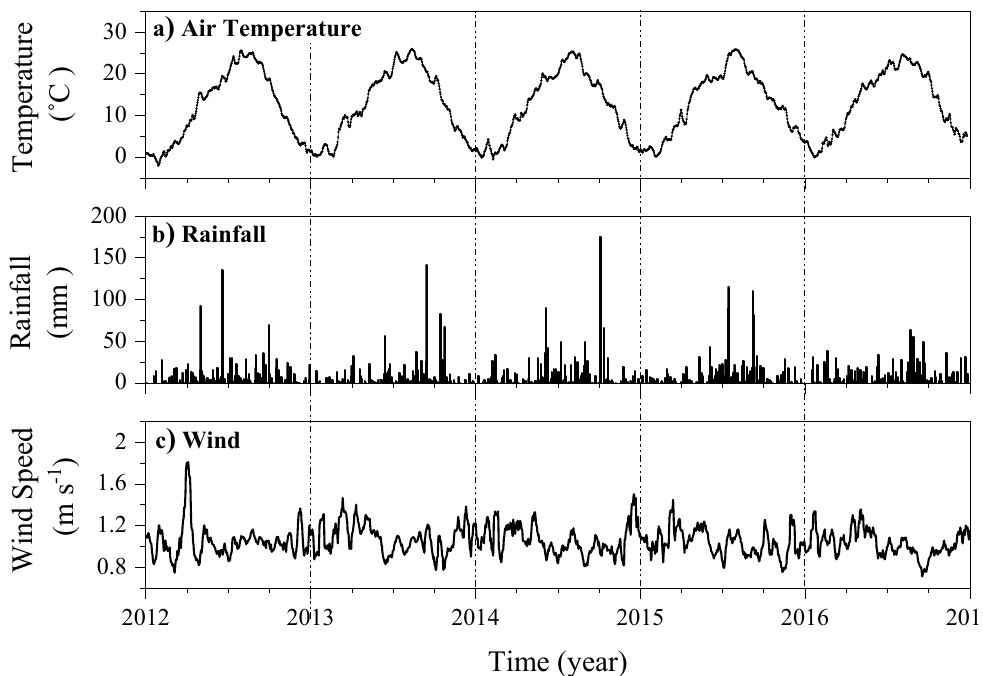
Figure 2. Typical variation of ( a ) air temperature (11-day moving average), ( b ) rainfall, and ( c ) wind speed from 2012 to 2016 from the dam station.